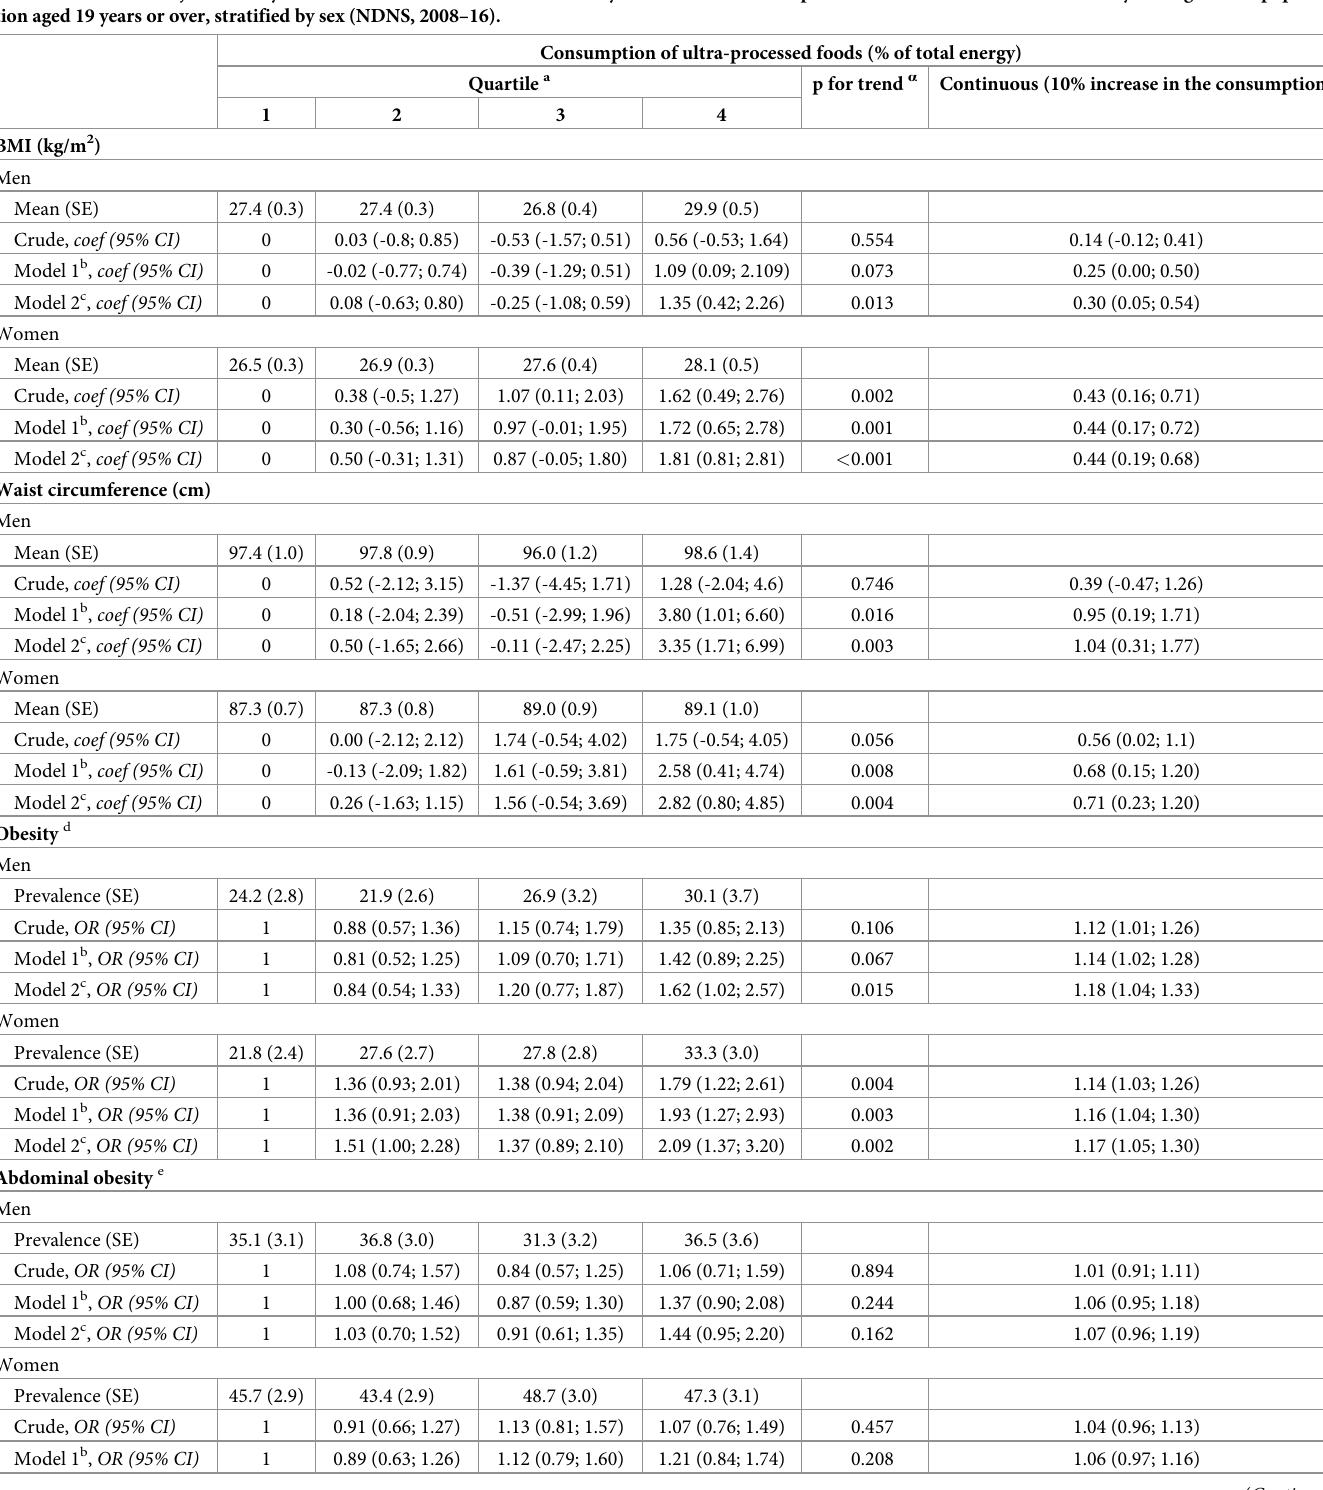
Table 4. Crude and adjusted analyses of the association between the dietary contribution of ultra-processed food and indicators of obesity among the UK popula- tion aged 19 years or over, stratified by sex (NDNS, 2008–16). Consumption of ultra-processed foods (% of total energy) Quartile a p for trend α Continuous (10% increase in the